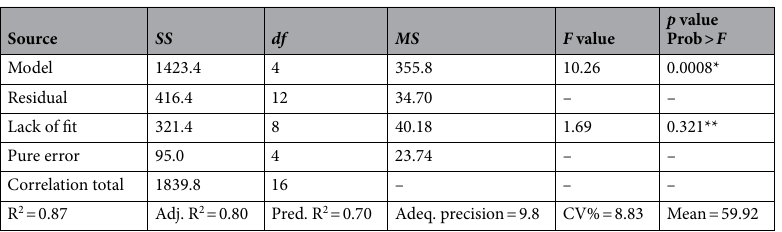
Source SS df MS